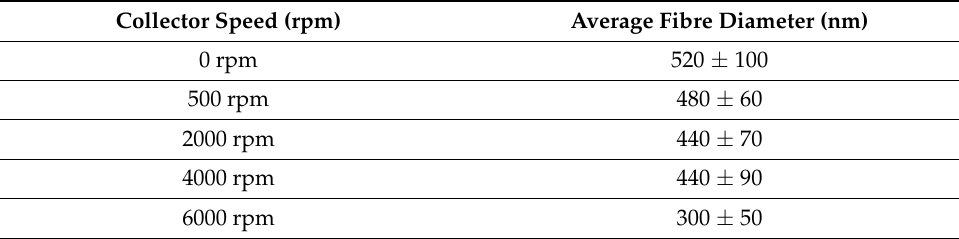
Table 1. Average diameter of electrospun